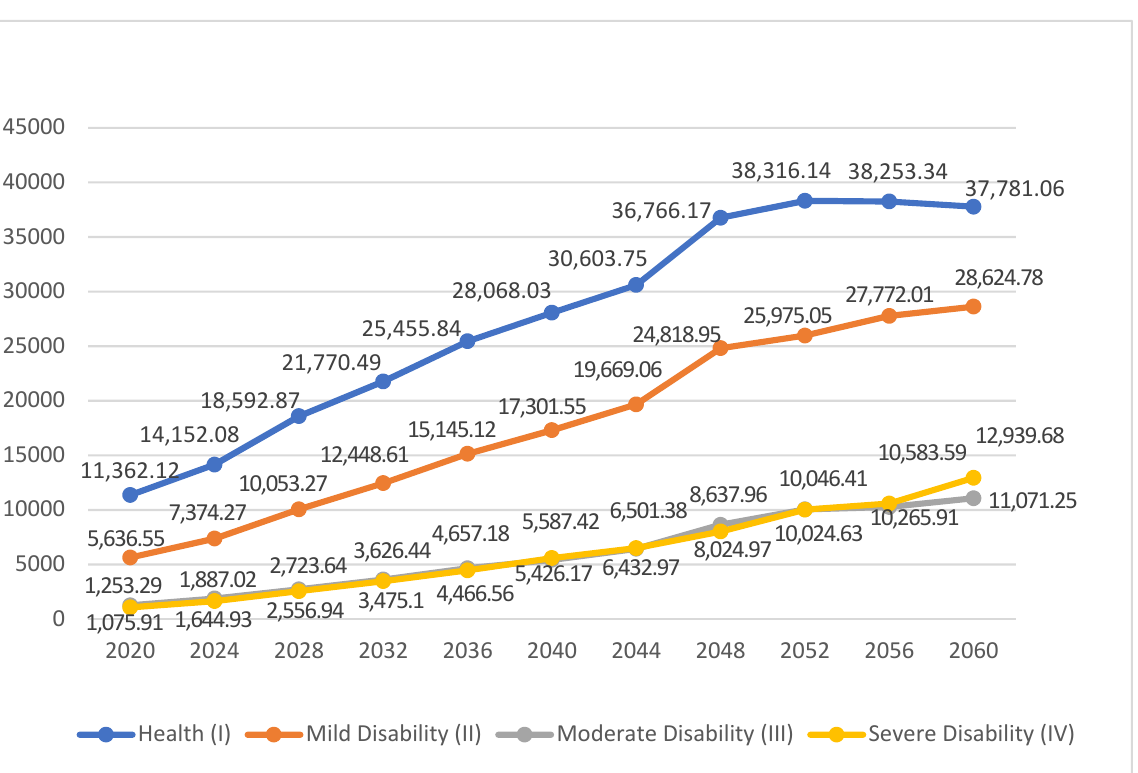
Figure 1. Prediction of annual medical expenditure for the elderly in China, 2020–2060.